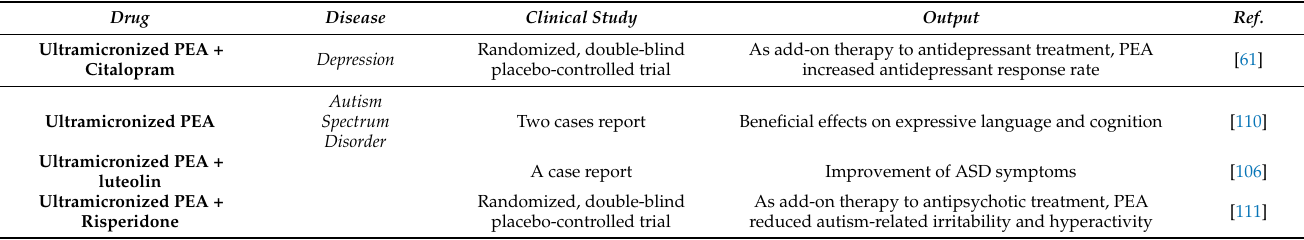
Table 2. Overview of primary findings in clinical studies providing evidence for a role of PPAR α in neuropsychiatric